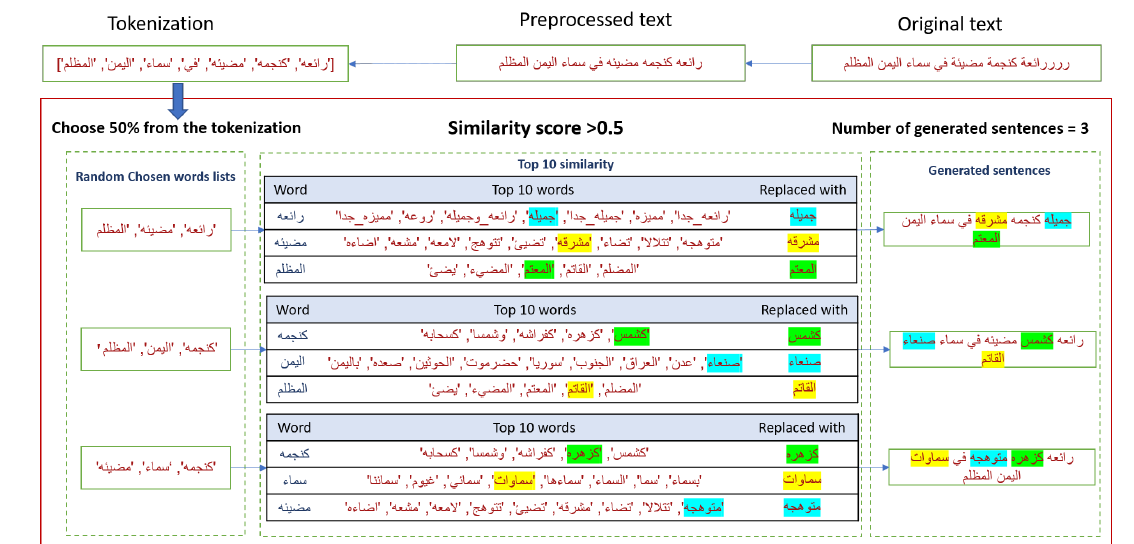
Figure 3. Arabic text data augmentation example. (The colors represent the selected words and each word is distinguished by a different